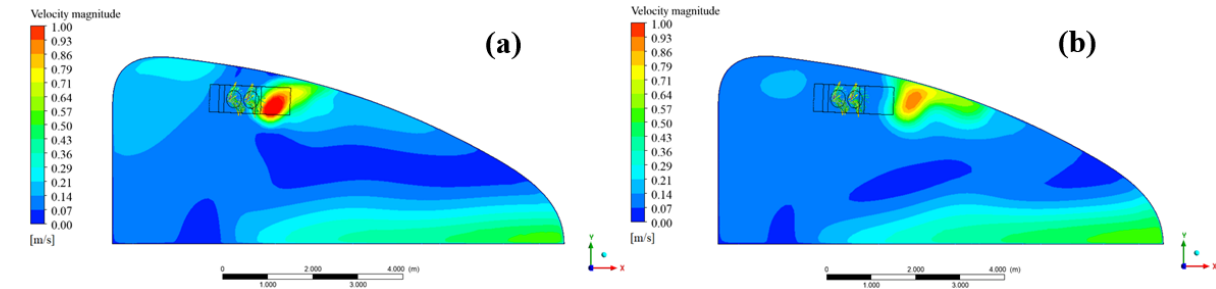
Figure 18. Velocity distribution contours for vertical profiles when the side opening angle was 60°: plane A ( a ) and plane C ( b ).